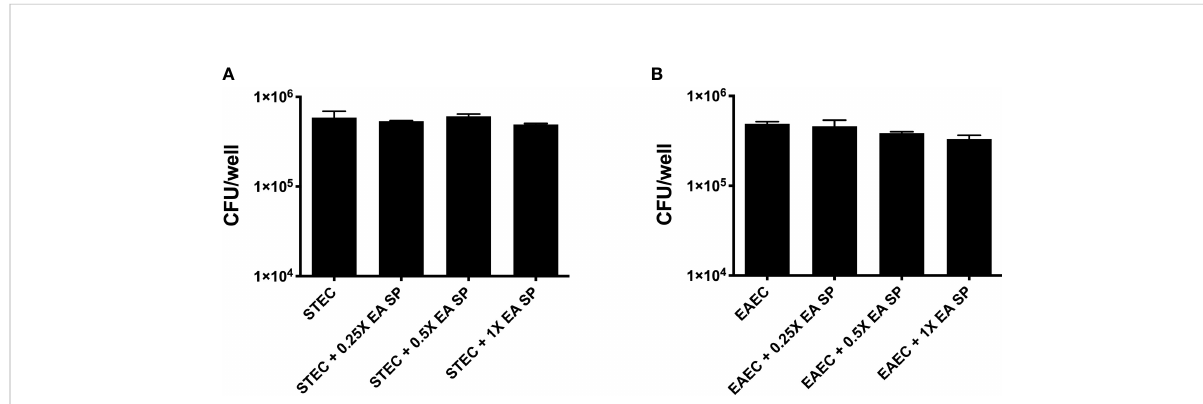
FIGURE 6 Adherence of STEC and EAEC to intestinal cells in the presence of EA SP.T84 cells were infected with STEC (A) or EAEC (B) in the presence of different concentrations of the supernatant obtained from the overnight growth of E. albertii (EA SP). After 3 h of infection, the number of adherent bacteria was determined by counting colony-forming units (CFU) in LB agar plates. Results are expressed as the means ± the standard errors for one of three experiments done in triplicate. Difference between groups were tested by ANOVA and multiple comparison